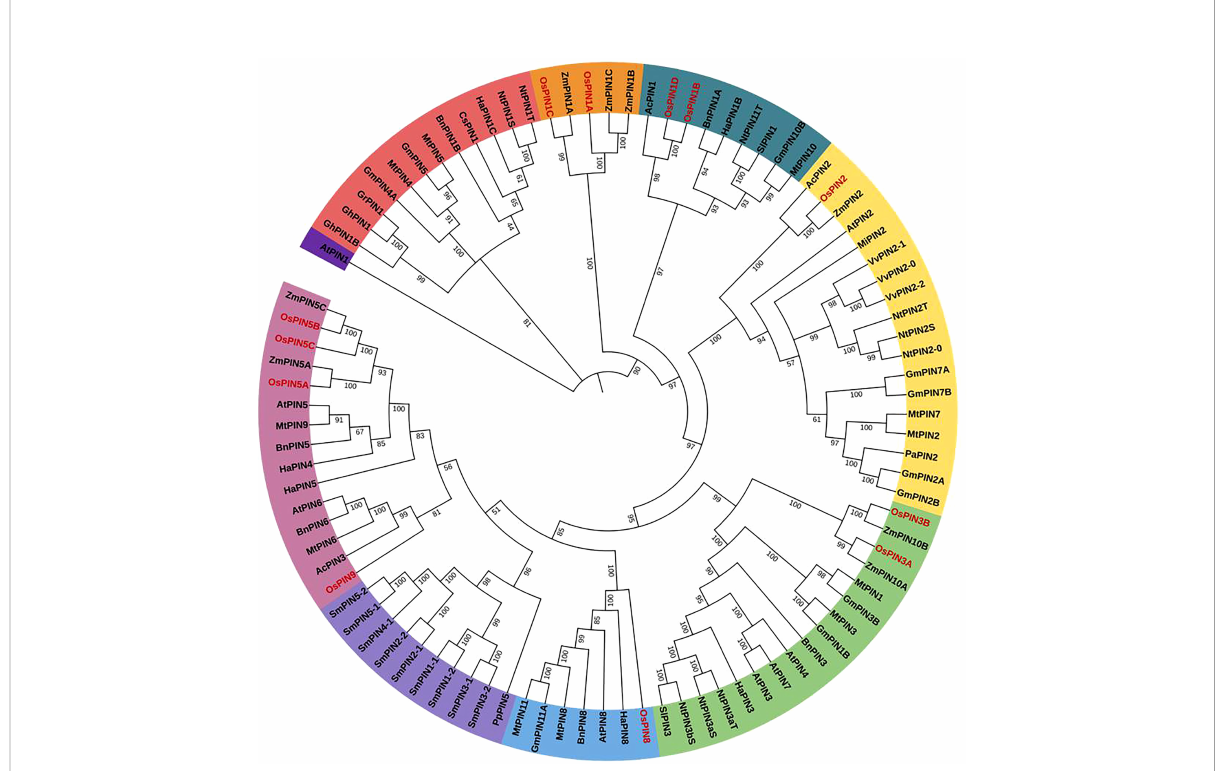
FIGURE 2 The phylogenetic relationship of PIN proteins of different plant species across the plant kingdom. A maximum likelihood method using 1,000 ultrafast bootstrap replicates was used to construct the tree. The OsPINs are labeled in red. The phylogenetic tree clustered into eight major groups was depicted in different